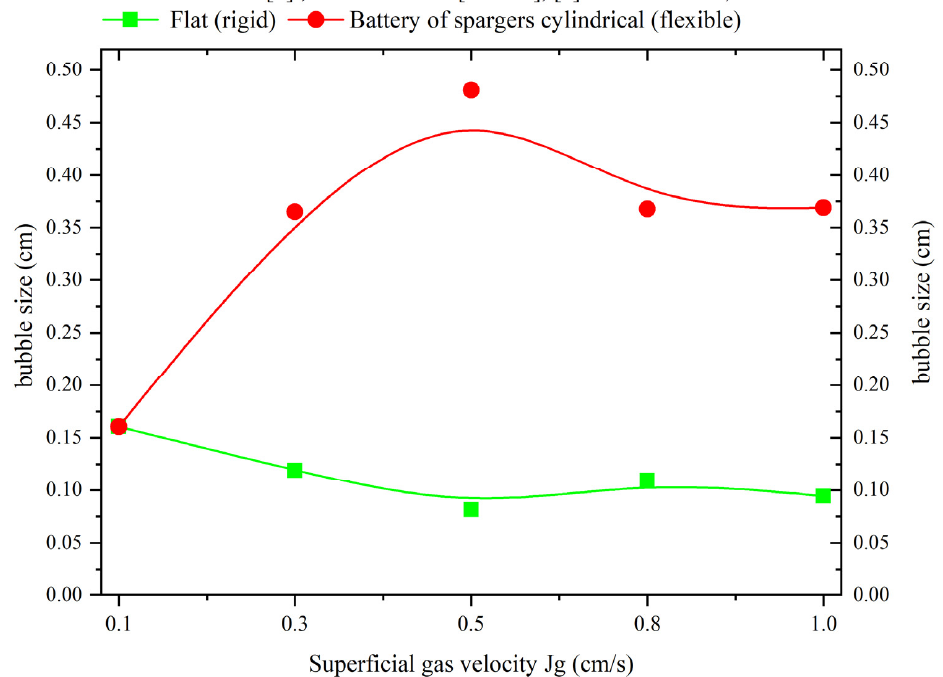
Figure 19. The effect of dispersion gas system bubble size (cm) vs. superficial gas velocity, Jg (cm/s), Figure 19. The e ff ect of dispersion gas system bubble size (cm) vs. super fi cial gas velocity, Jg (cm/s), 1.89 × 10 − 4 M [x], 1.29 × 10 − 4 M [xl2945], and [e] 1.25 × 10 − 4 1.89 × 10 − 4 M [x], 1.29 × 10 − 4 M [xl2945], and [e] 1.25 × 10 − 4 M.